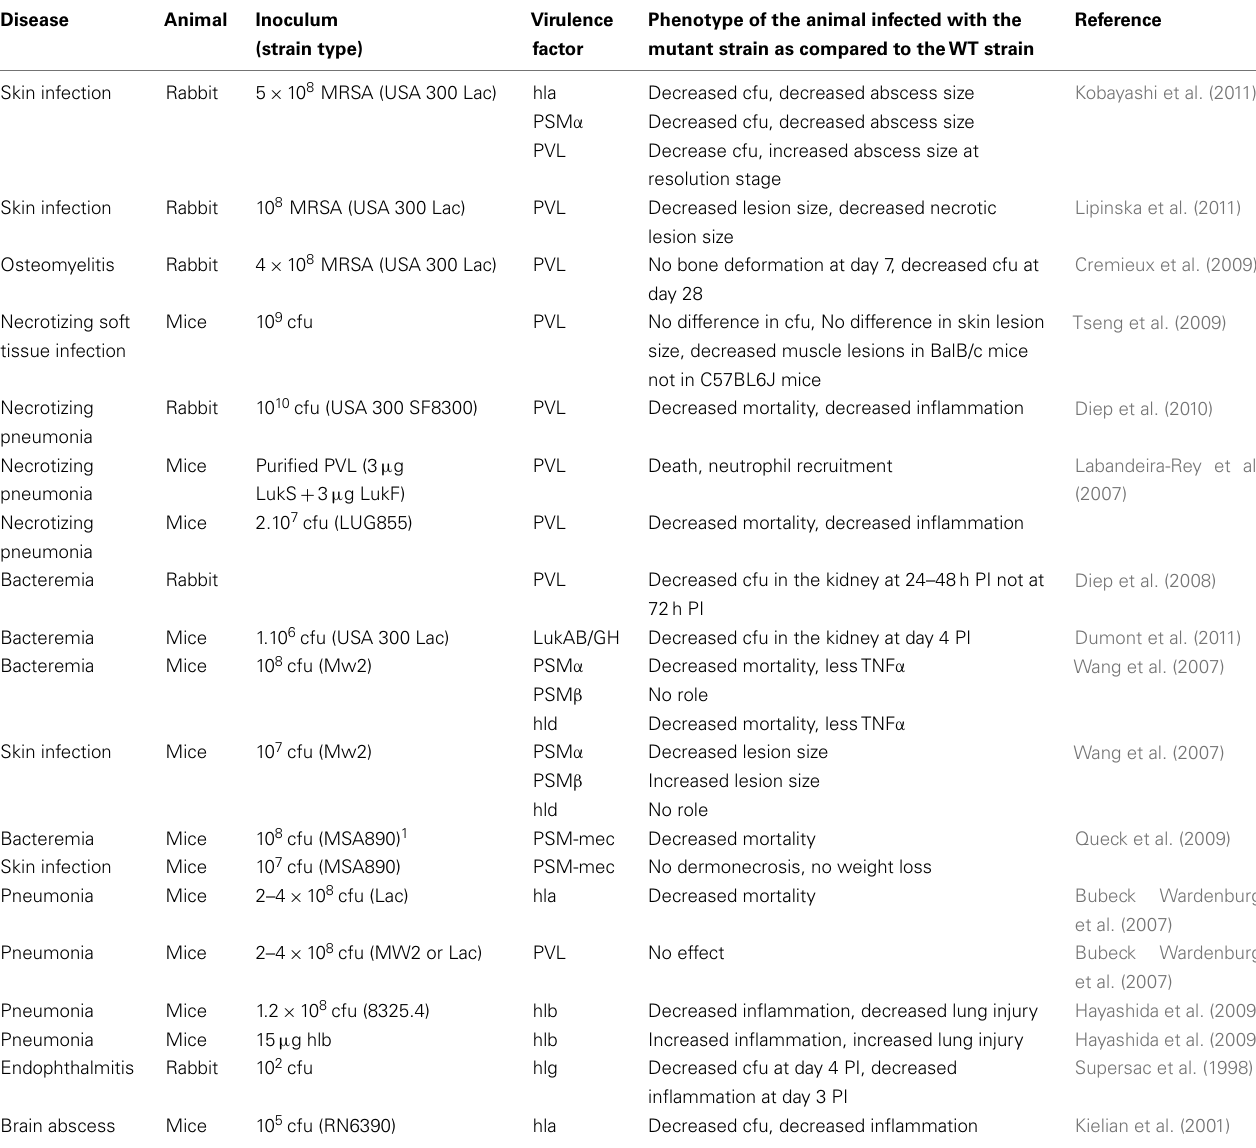
Table 2 | Membrane-damaging factors and their role in various diseases in various animal models. Disease Phenotype of the animal infected with the mutant strain as compared to theWT